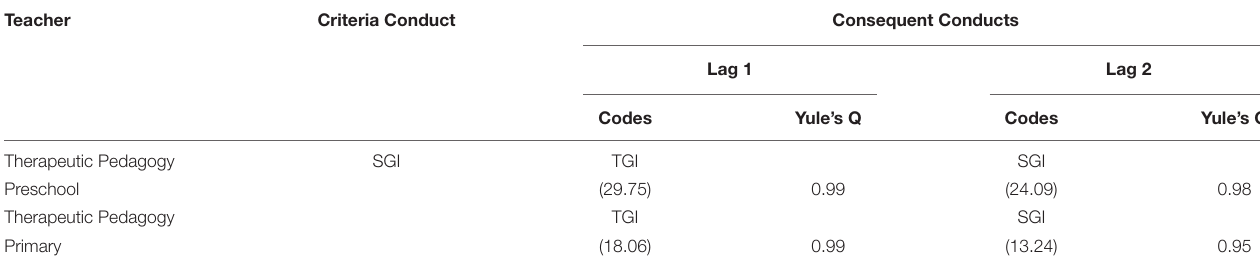
TABLE 14 | Neutral Interventions of